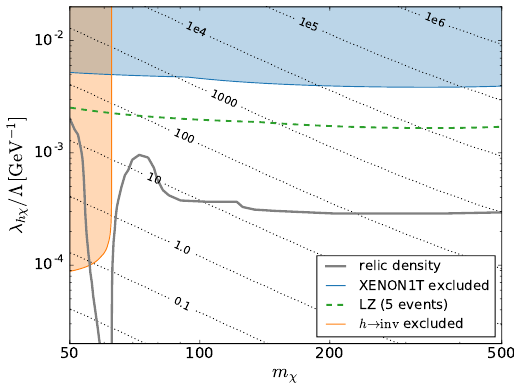
Figure 13 . Same as (cid:12)gure 9 but including the UV-divergent diagrams shown in (cid:12)gure 12 for (cid:3) = 1